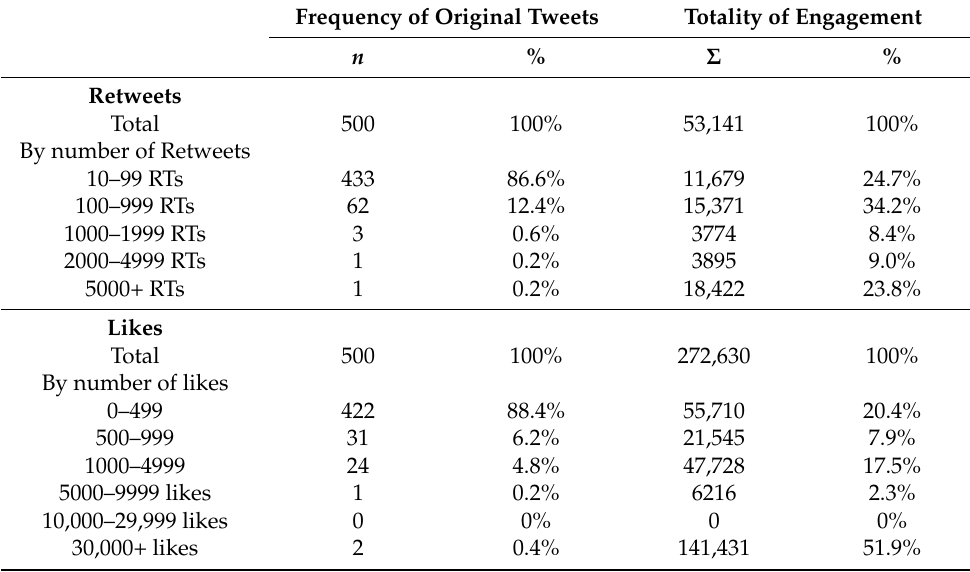
Table 1. Descriptive statistics of retweets and likes of the original